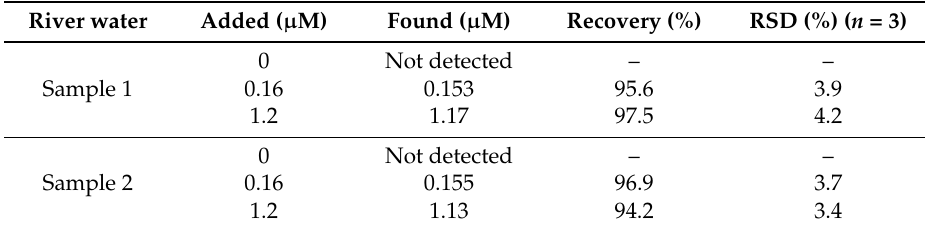
Table 3. Analysis of 2,4 ‐ DCP in spiked water samples.